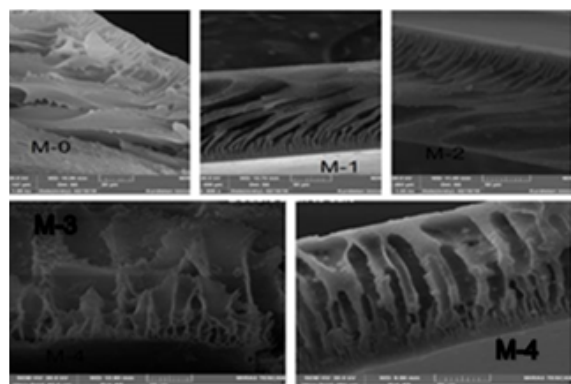
Figure 3. The SEM of upper surface of the synthesized